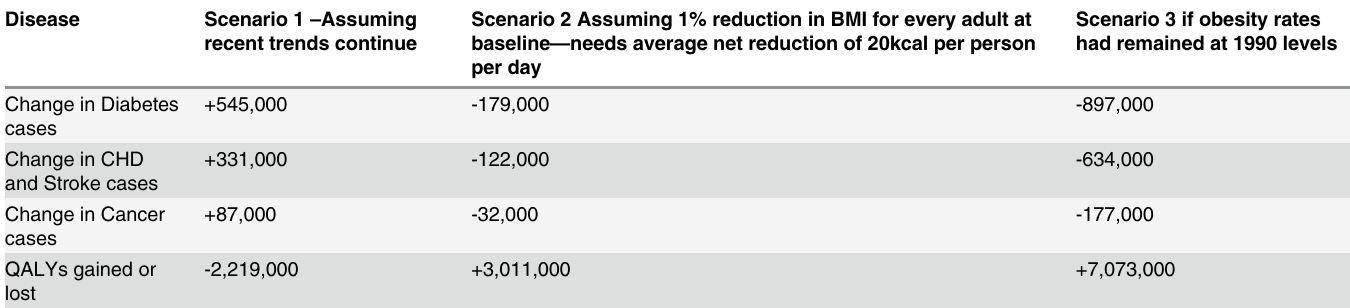
Table 2. Outcomes associated with obesity scenarios, from Wang et al. Change in disease cases (incidence) and QALYs, 2010 – 2030, United Kingdom. Disease Scenario 1 – Assuming recent trends continue